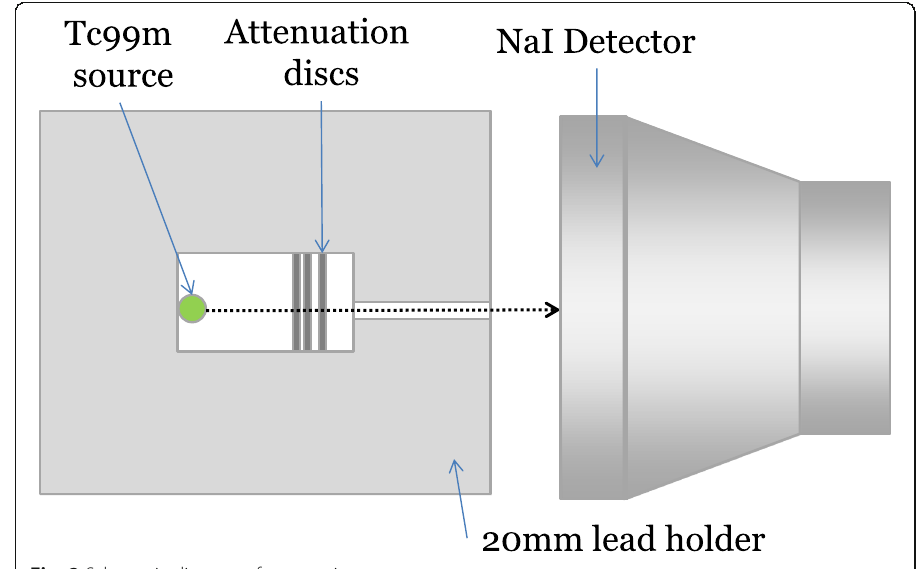
Fig. 2 Schematic diagram of attenuation